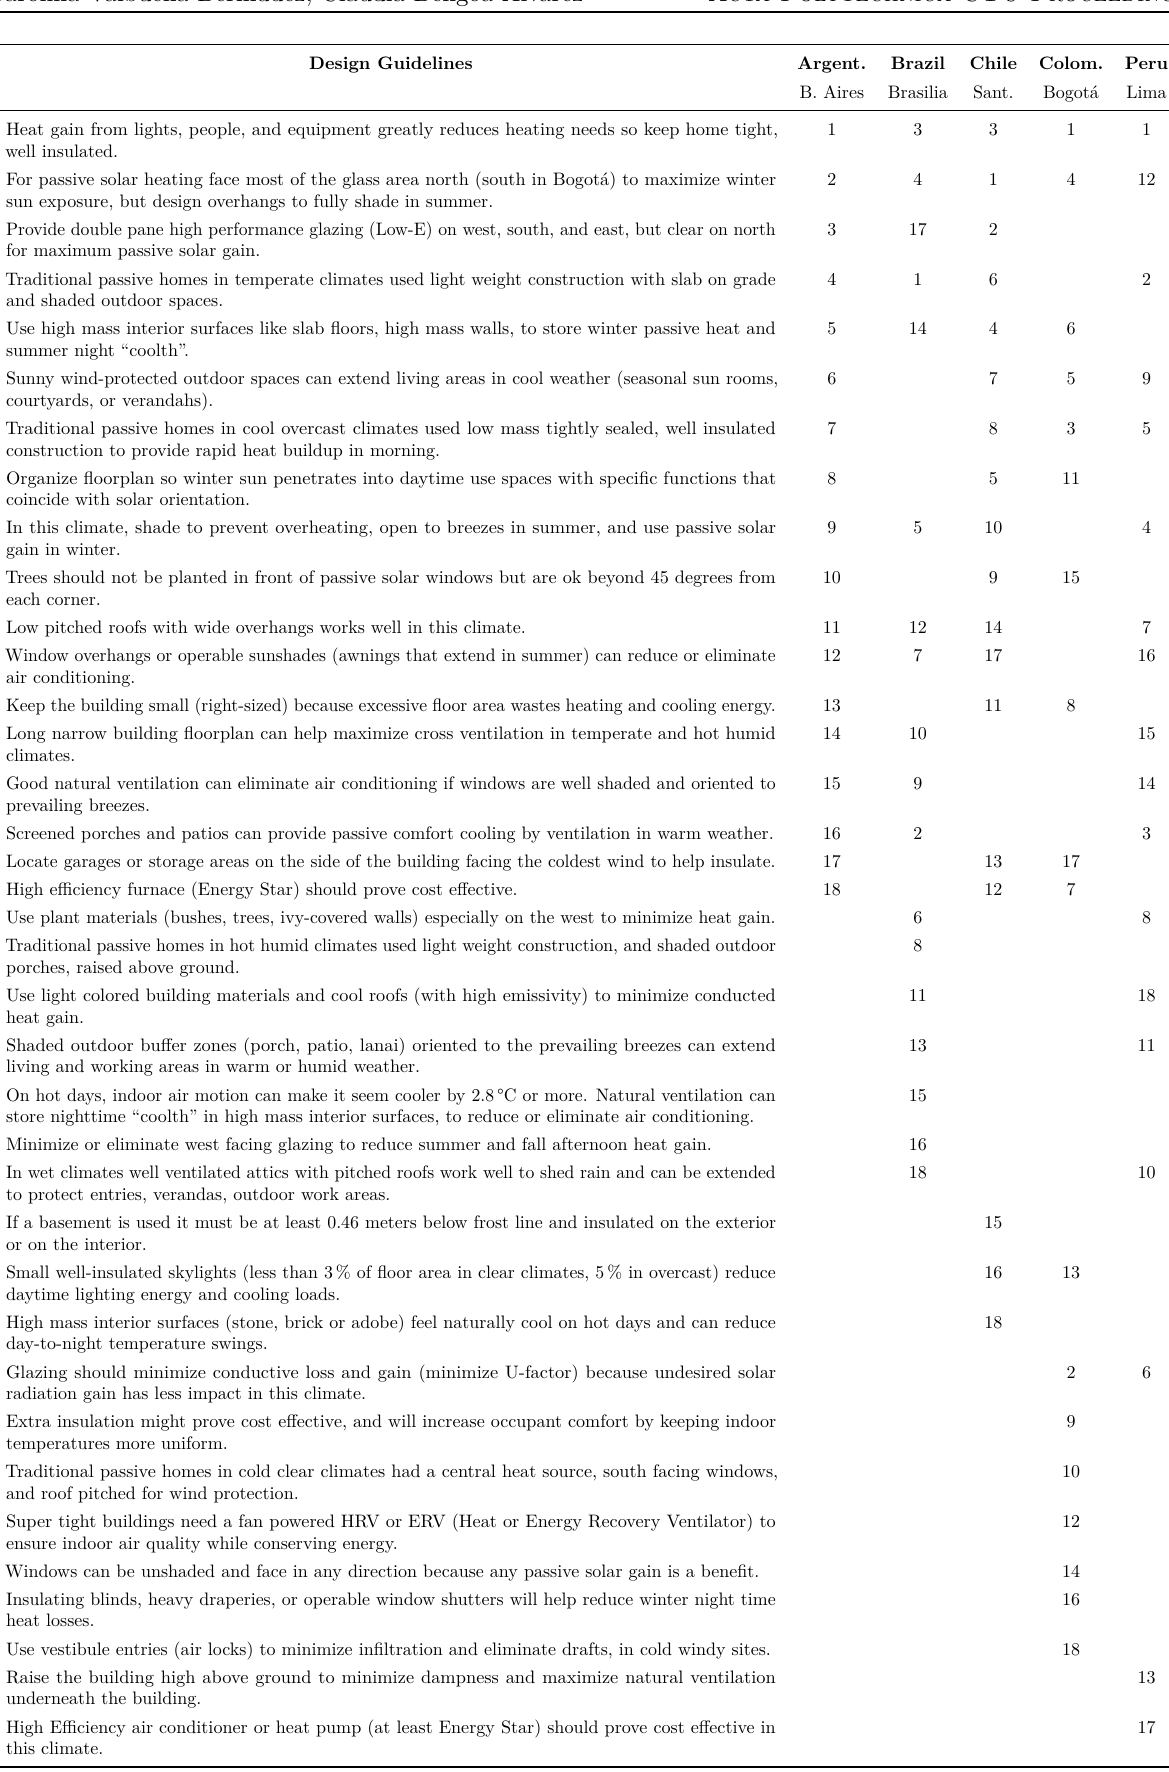
Table 2. Design Guidelines for 5 Latin American